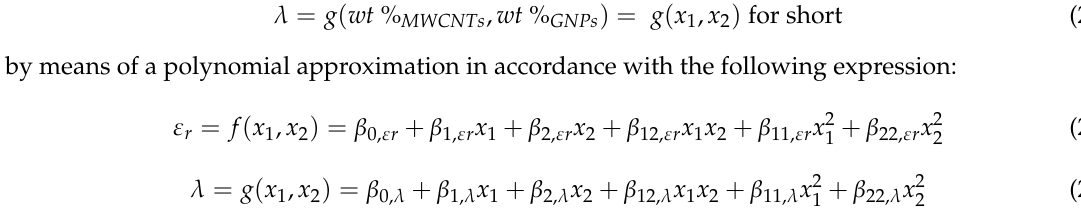
Table 3. RSM coefficients for the quadratic response of the relative permittivity and the thermal conductivity experimental data.